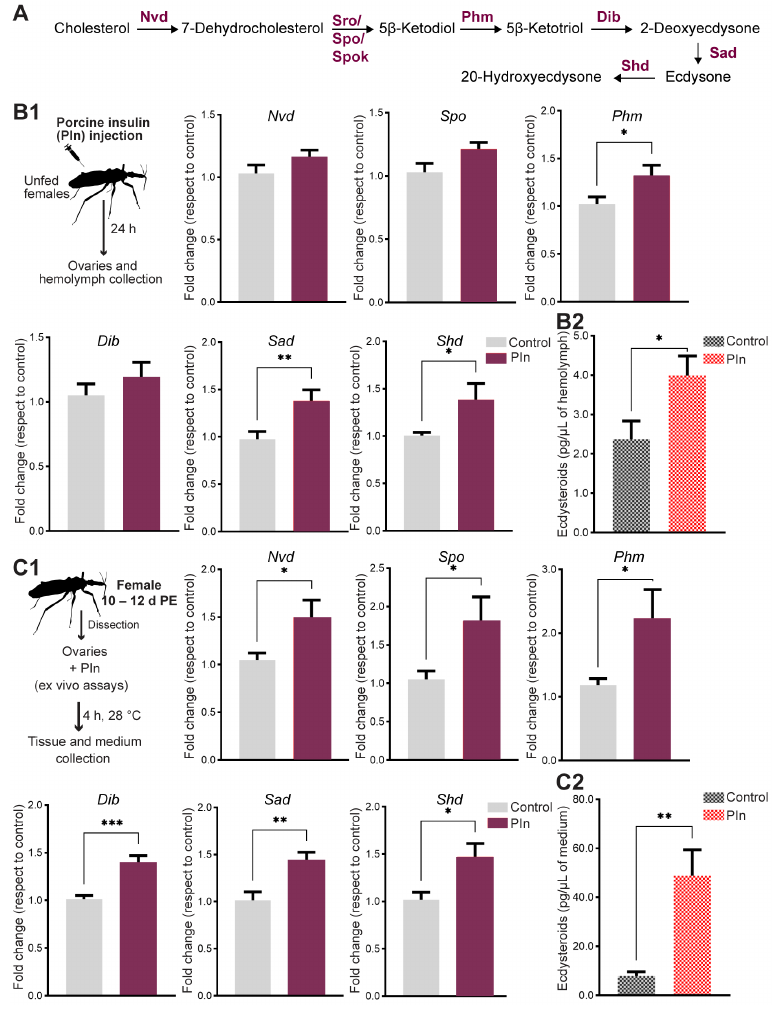
Figure 7. Role of insulin in ecdysteroid production. ( A ) Scheme of ecdysteroid biosynthesis. ( B1 ) Unfed adult females were injected with porcine insulin (PIn, 0.5 µg diluted in saline) and 24 h later